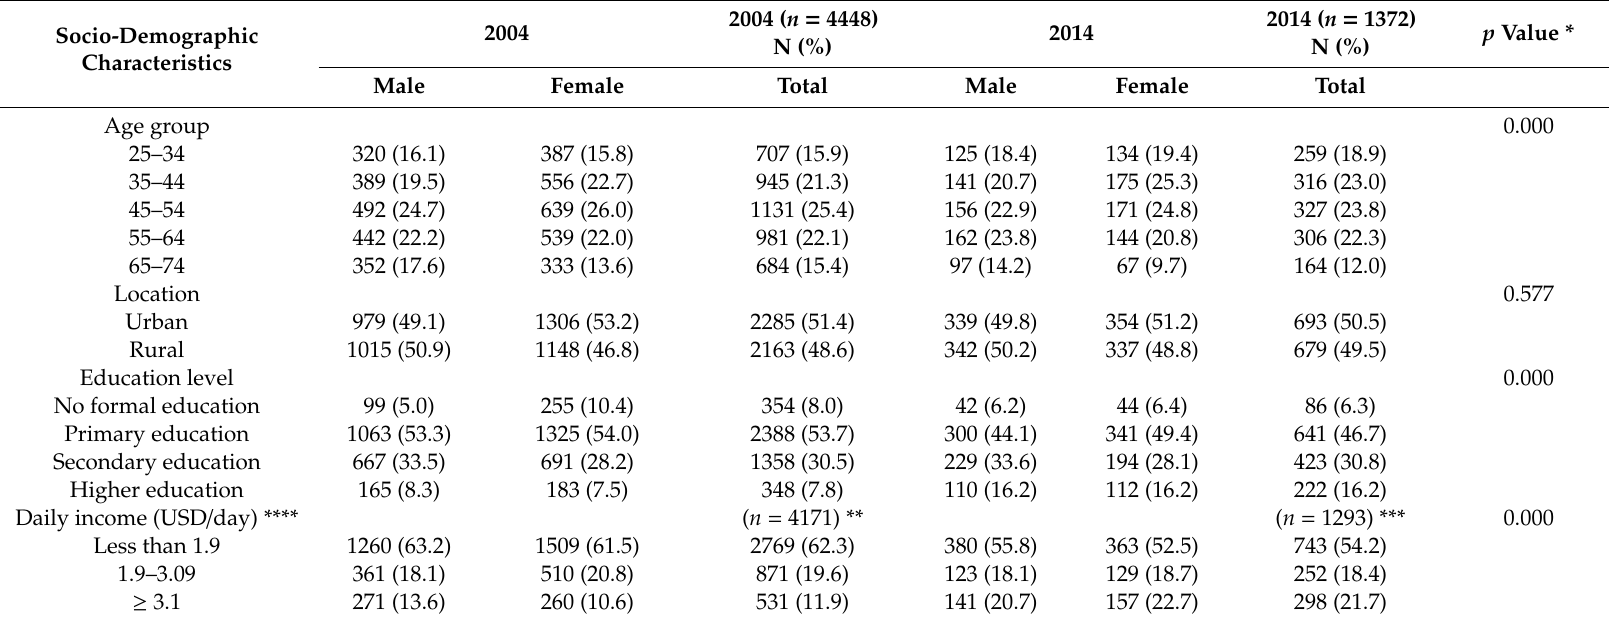
Table 1. Socio-demographic characteristics of 25–74-year-old citizens in the Yangon Region, Myanmar by study year and gender.